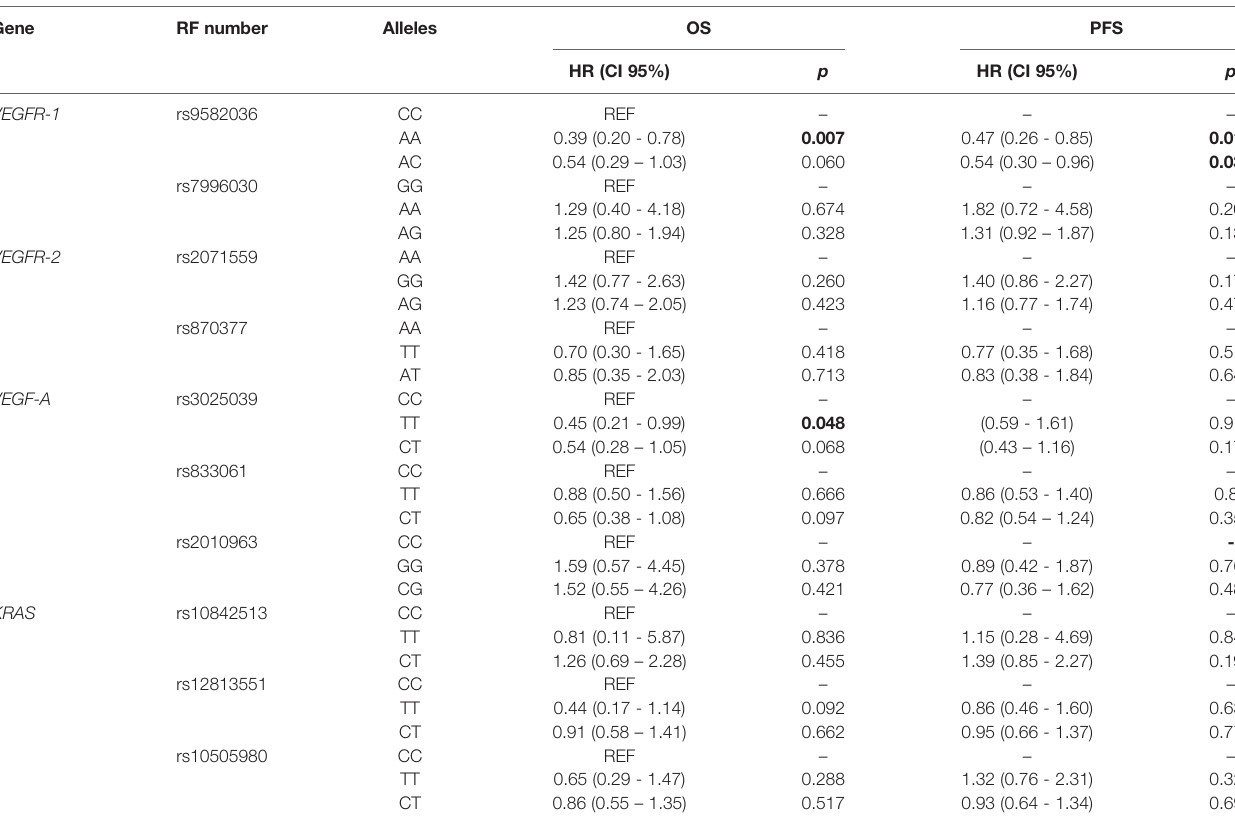
TABLE 4 | Association of SNPs in VEGFA , VEGFR1 , VEGFR2 , and KRAS genes with OS and PFS. Gene RF number Alleles